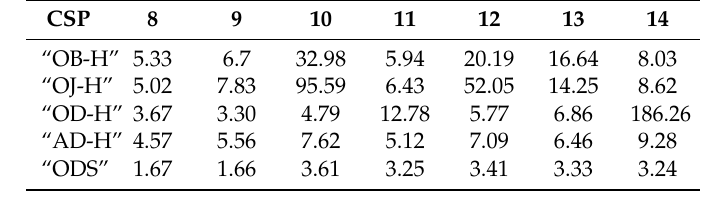
Table 2. Relative retention of isomeric acetyl PAHs. See Scheme 1 for analyte structure. CSP